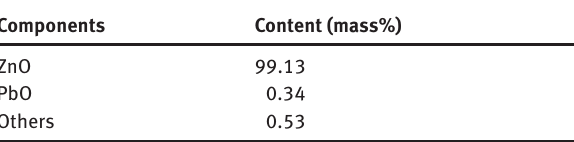
Table 6: Chemical composition of the collected Zn-product Components